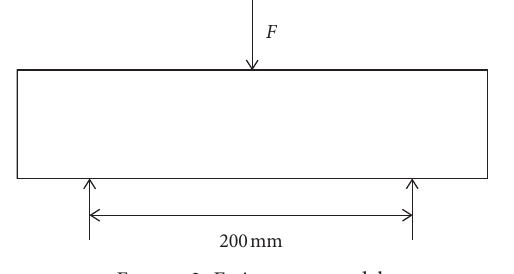
Figure 3: Fatigue test